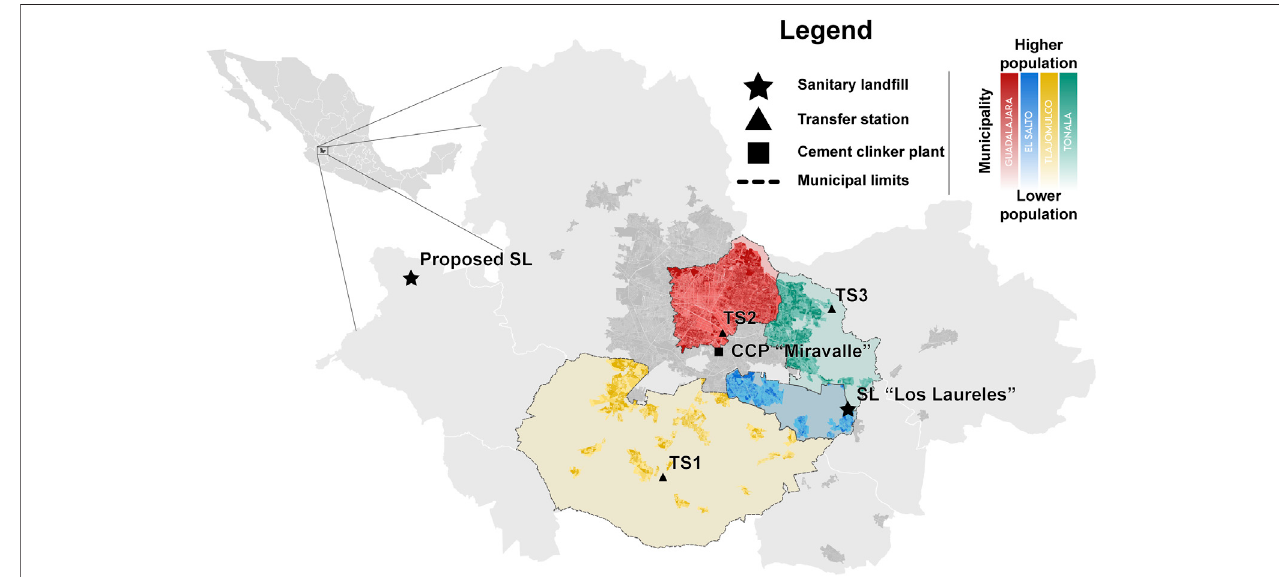
FIGURE1| GMAsubsystem understudyandlocationofMSWmanagementfacilitiesinthearea.SanitaryLand fi ll(SL),TransferStation ‘ LaCajilota ’ (TS1),Transfer Station ‘ 18 de marzo ’ (TS2), Transfer Station ‘ Coyula Matatlan ’ (TS3), Cement clinker plant ‘ Miravalle ’ (CCP).